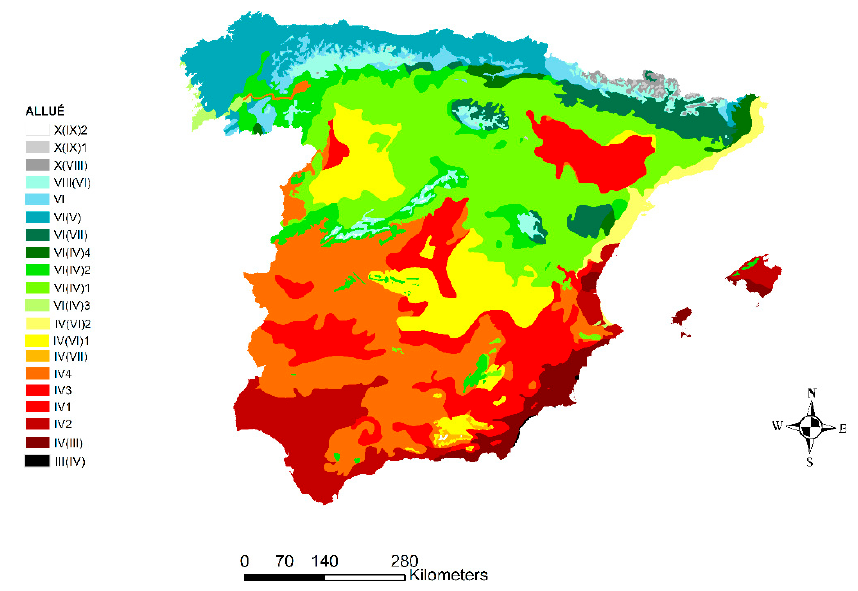
Figure 3. Map of Allué phytoclimatic types or zones in mainland Spain and the Balearic Islands.